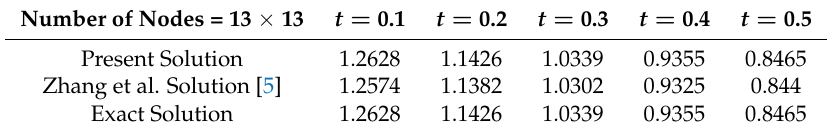
Table 2. Numerical solution of ρ ( x , y , t ) at x = 0.5, y = 0.5 compared with exact solution and Zhang et al. [5] (Example 1).